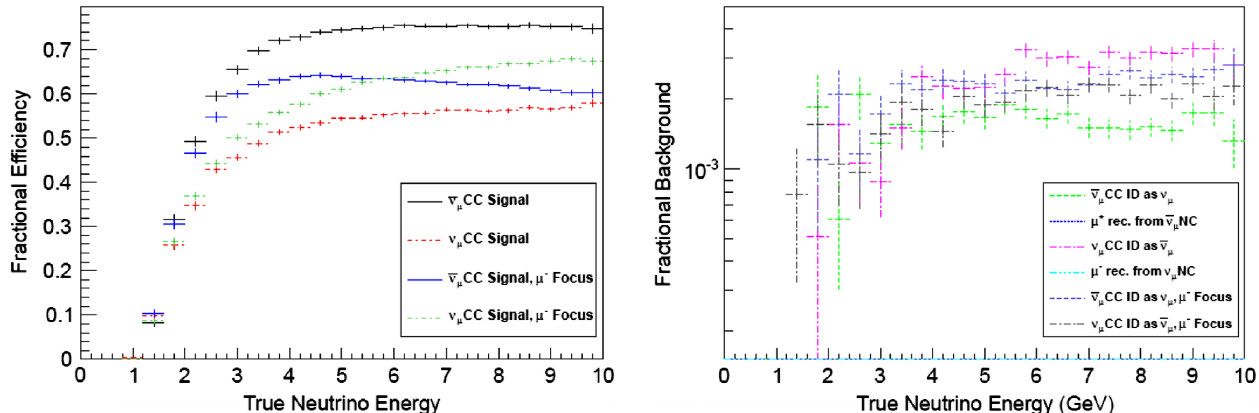
FIG. 20. Performance of the MIND detector. (Left) The efficiency for detecting the muon signal events. (Right) The fractional backgrounds.